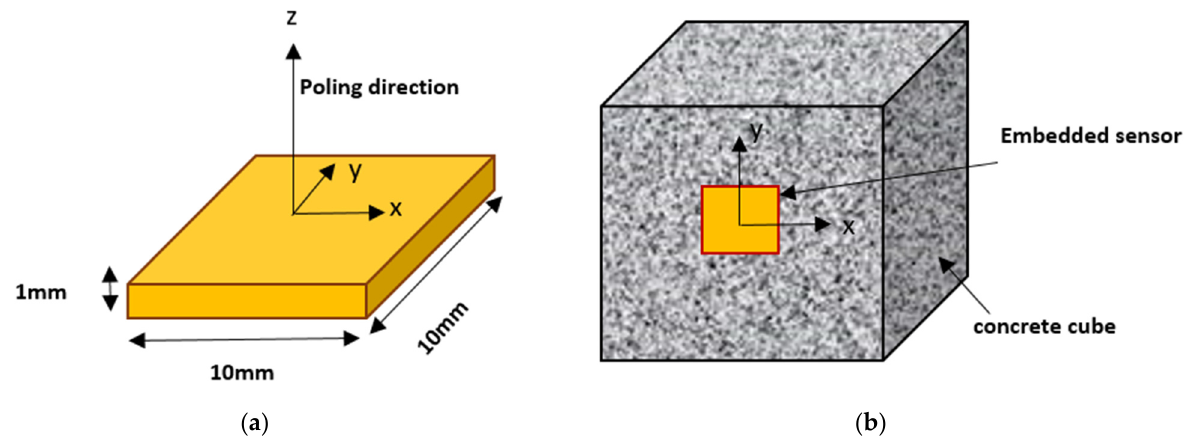
Figure 1. Schematic diagram: ( a ) PZT patch; ( b ) Concrete cube with embedded PZT transducer.